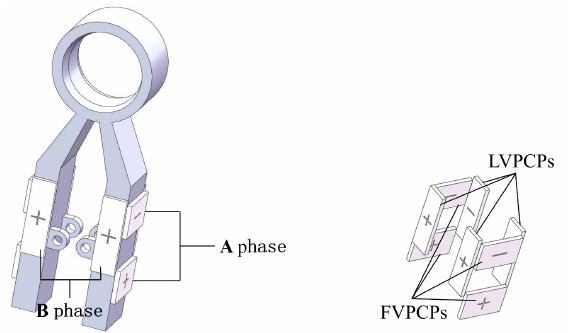
Figure 7. Structural scheme of the